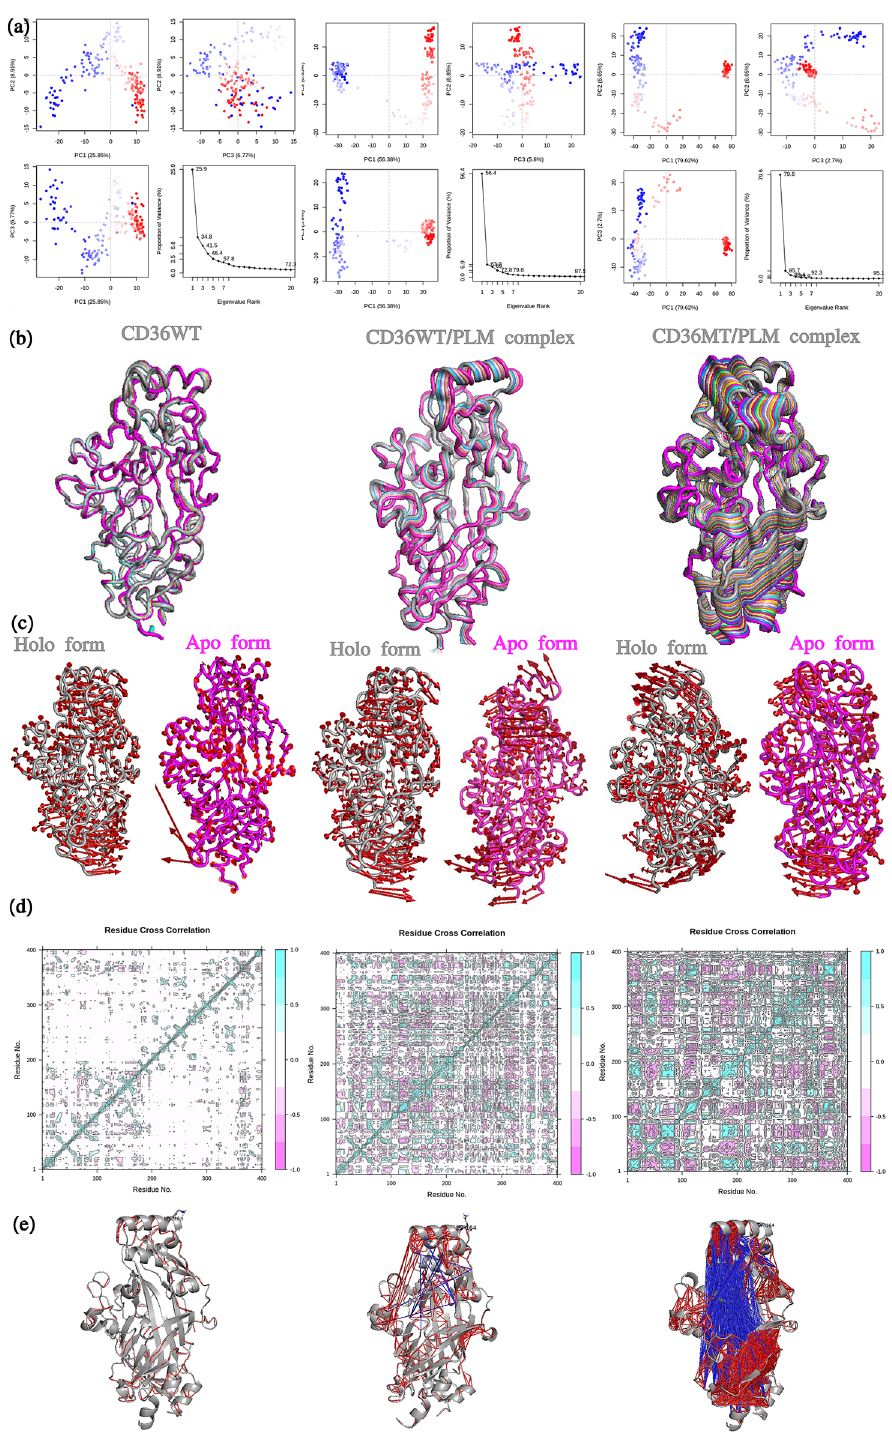
Figure 3. ( a–c ) Model and motion produced by principal component analysis for wild and mutant type of CD36 in presence and absence of PLM a function of time during 100,000 ps (100 ns). ( a ) Principal component analysis, PC2 vs PC1, PC2 vs PC3, PC3 vs PC1 and an eigenvalue rank plot. ( b ) Visualization of the motions along PC1. ( c ) Motion of two different modes by ANM Analyze, the red arrows show the direction and amplitudes of the movements occurred from first trajectory of holo and apo form in (gray) and (pink) color respectively. ( d,e ) Cross-correlation Analysis matrix of the fluctuations of the C α atoms of the residue from their average during 100 ns for wild and mutant type of CD36 in presence and absence of PLM. ( d ) Cross- correlation map for MD simulation. Cyan color indicates a positive correlation between residue fluctuations, while the pink color depicts a negative correlation. ( e ) Residue cross-correlations. CD36 is depicted by gray cartoon. Red and blue lines indicate correlated and anti-correlation